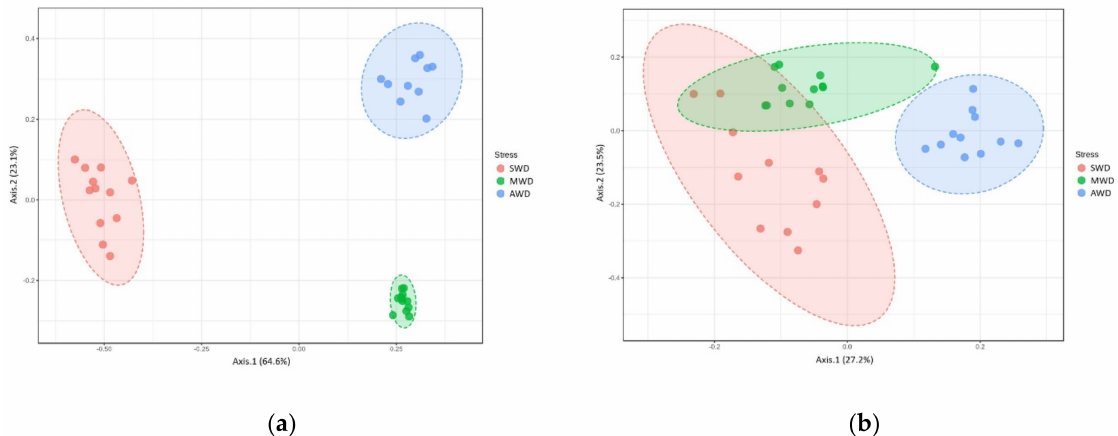
Figure 3. Principal Coordinate Analysis (PCoA) based on Bray–Curtis dissimilarity metrics, showing the distance in the fungal communities among irrigation regimes (SWD: severe water deficit, MWD: moderate water deficit, and AWD: absence of water deficit) at ( a ) 6-month sampling and ( b ) 12-month sampling times in the